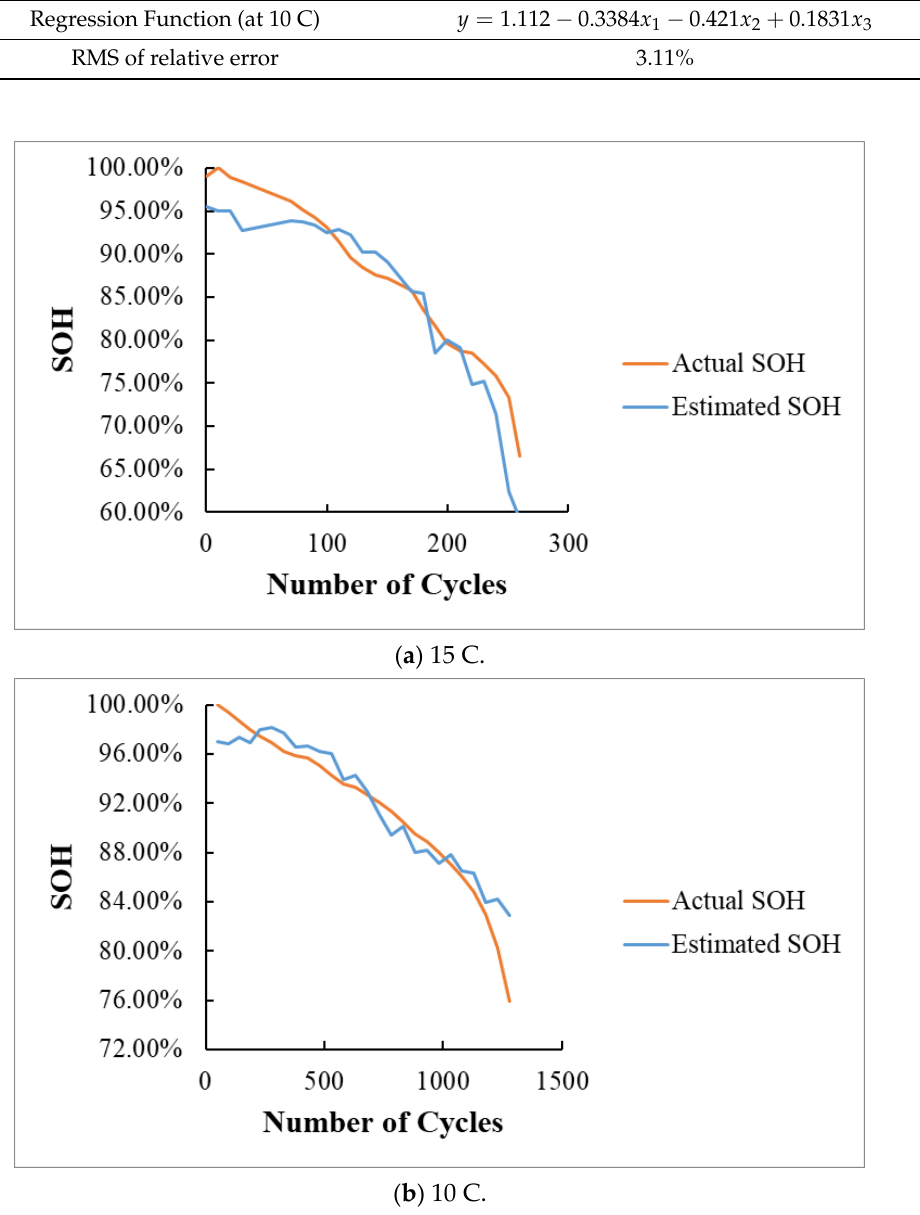
Figure 11. A comparison of the actual and predicted values of SOH (characteristic frequency